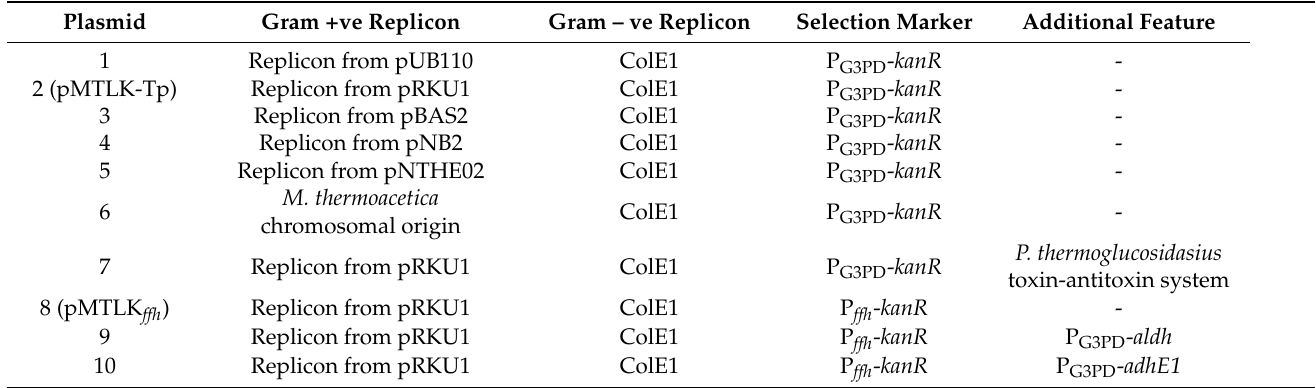
Table 2. List of plasmids created with their respective features. Further details on the specific features can be found in the Results